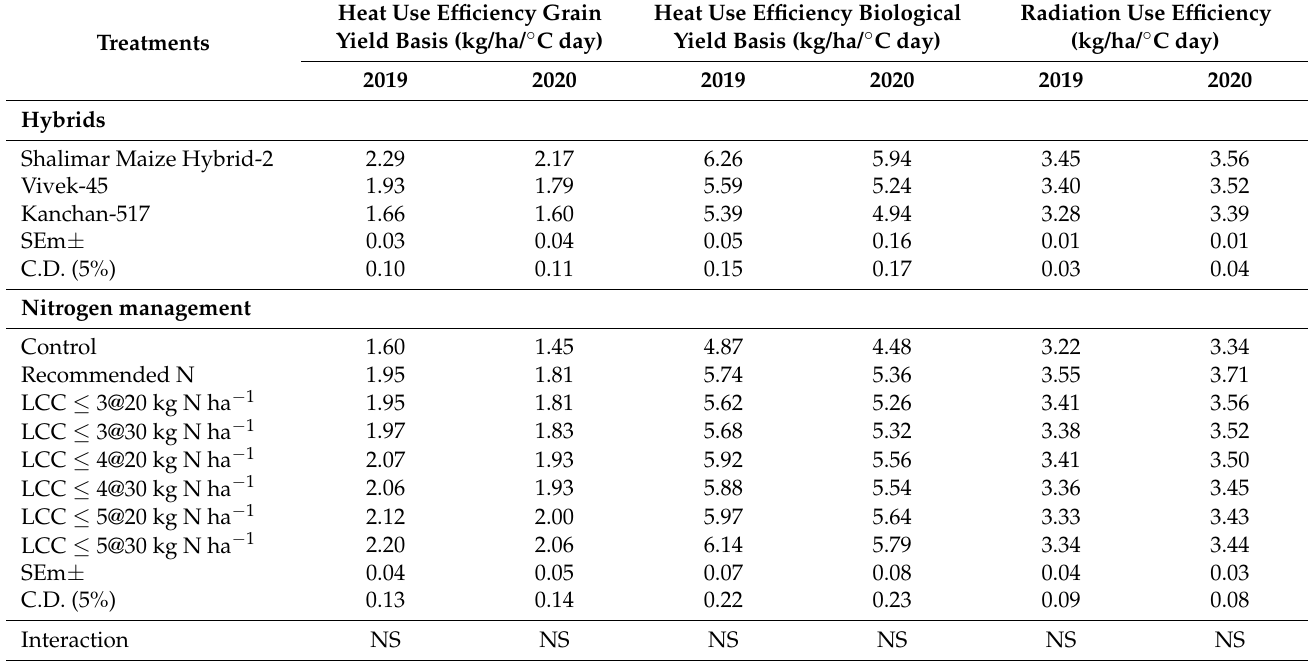
Table 8. Effect of precision nitrogen management through LCC on heat use efficiency on grain and biological yield basis and radiation use efficiency of different hybrid maize